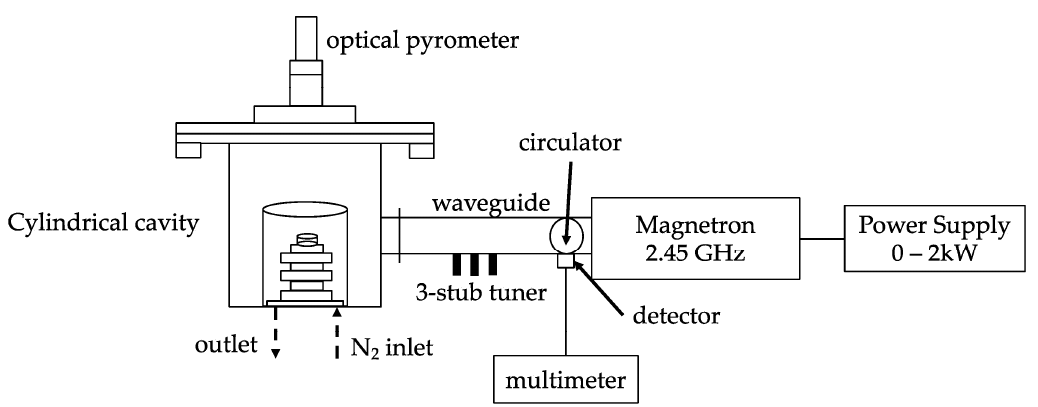
Figure 1. Schematic diagram of the microwave furnace.